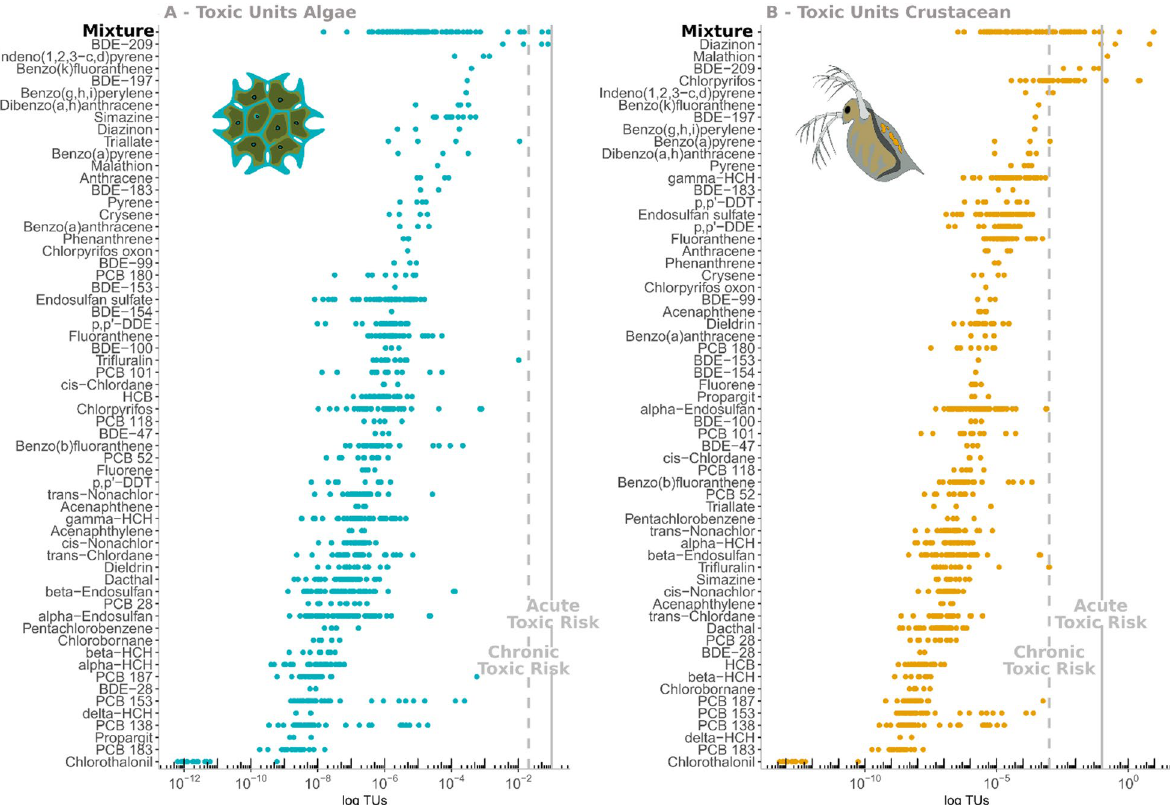
Fig. 1 Toxic risk by organic chemicals for crustaceans and algae in mountain lakes. TUs calculated from water concentrations stated in various studies (Table 1, except Machate et al. [19]) investigating the chemical pollution of mountain lakes from different parts of the world. “Mixture” displays the predicted mixture toxic risk of all compounds that have been measured at a given site ( ∑ TUs). Below, the individual toxic risks caused by each individual compound is displayed (TU) and they were sorted according to their median TUs (increasing from bottom to top). Thresholds for chronic and acute toxic risk are displayed in the form of a dashed and solid grey line,